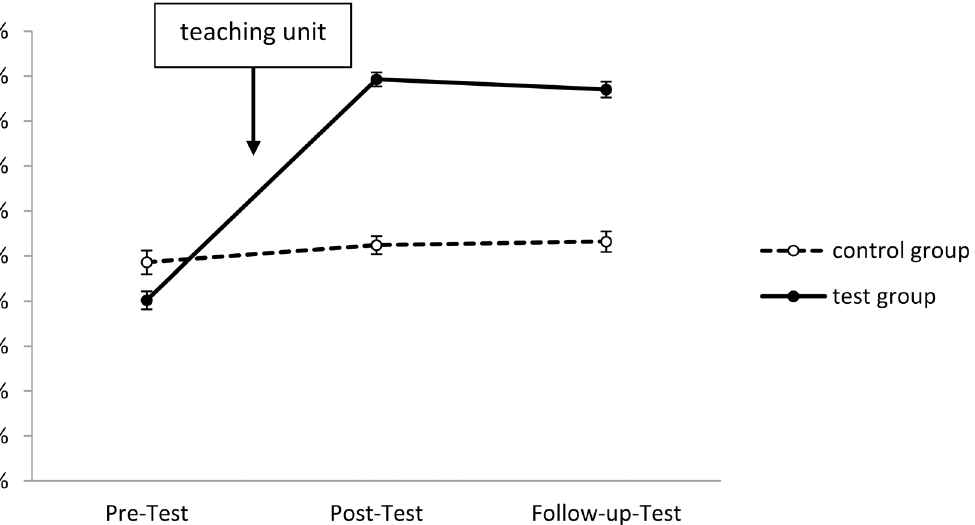
Fig 5. Development of first aid-related knowledge in test and control group (domain 5). Shown are solution rates (mean of all first aid-related-related items). For descriptives see S1